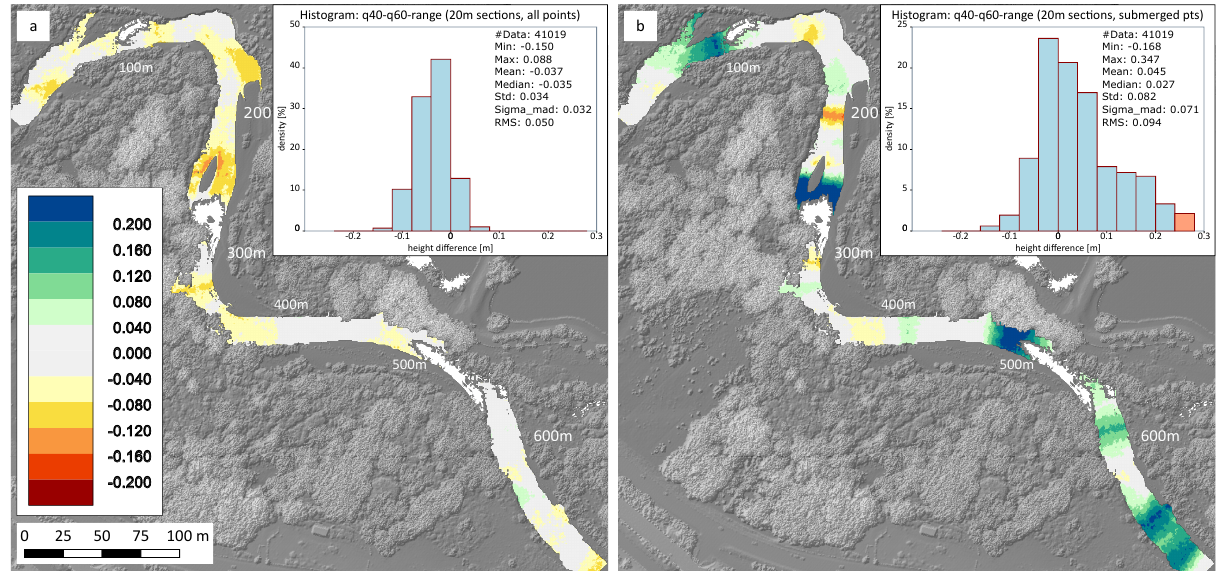
Figure 7. Deviations of modeled water surfaces from the reference water level derived from IR channel. (a) DWM derived from q40-q60-range for 20m sections; (b) as (a) with statistics based on submerged points only.